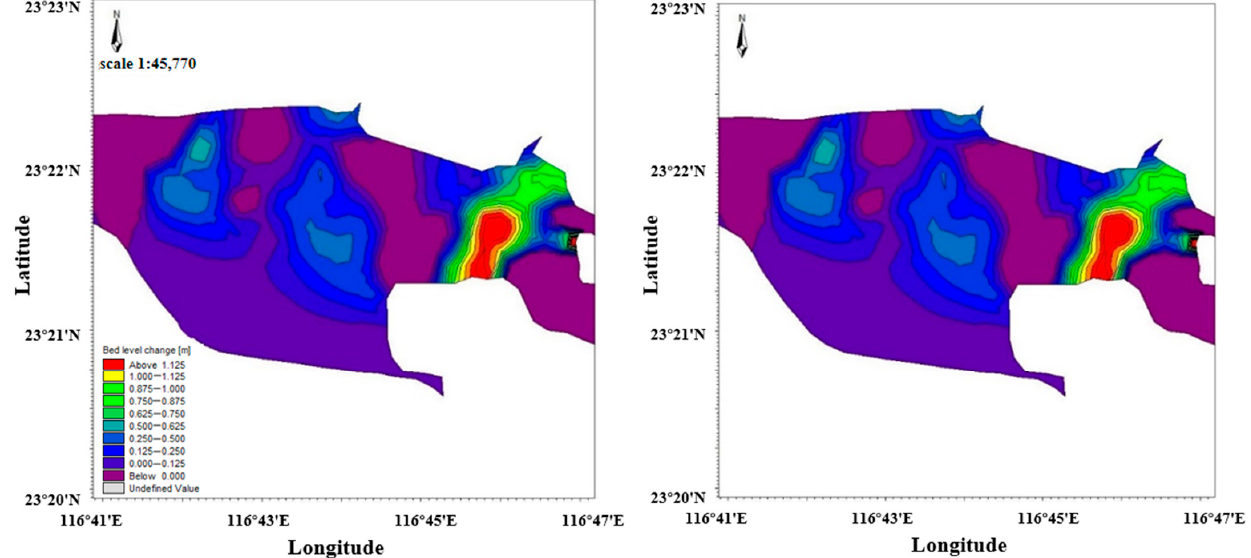
Figure 19. Changes of silts in Shantou Port before and after flood discharge of Hanjiang River.